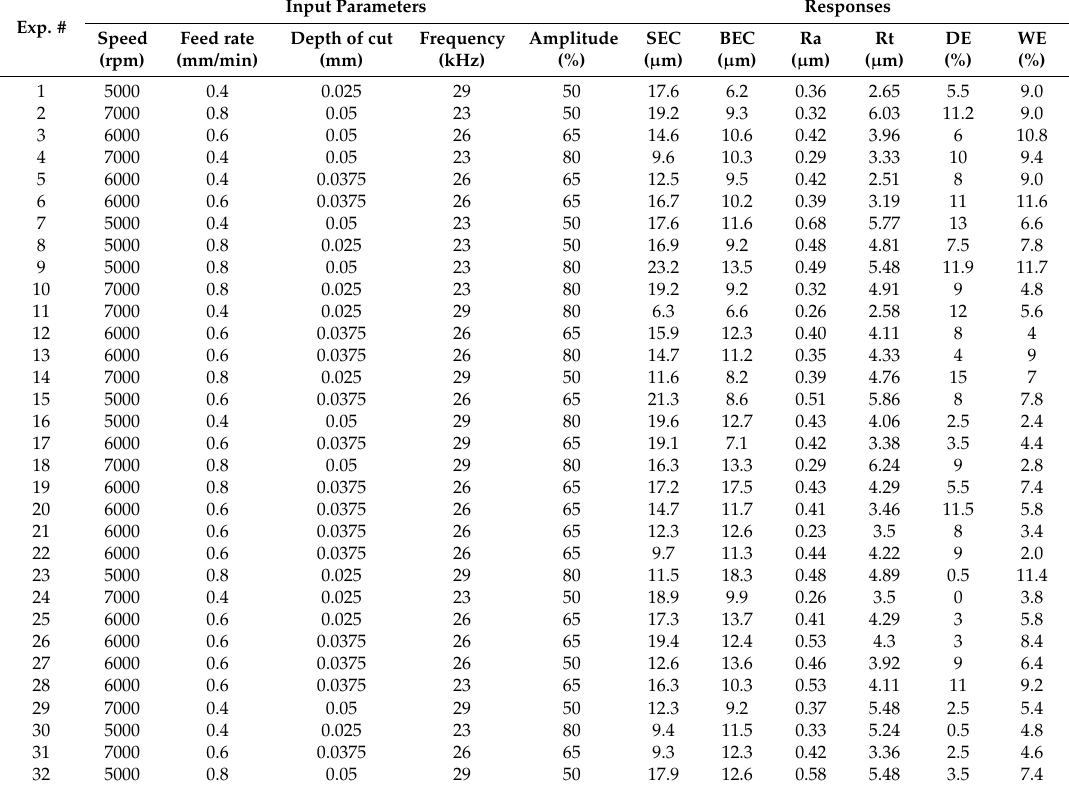
Table 3. Experimental